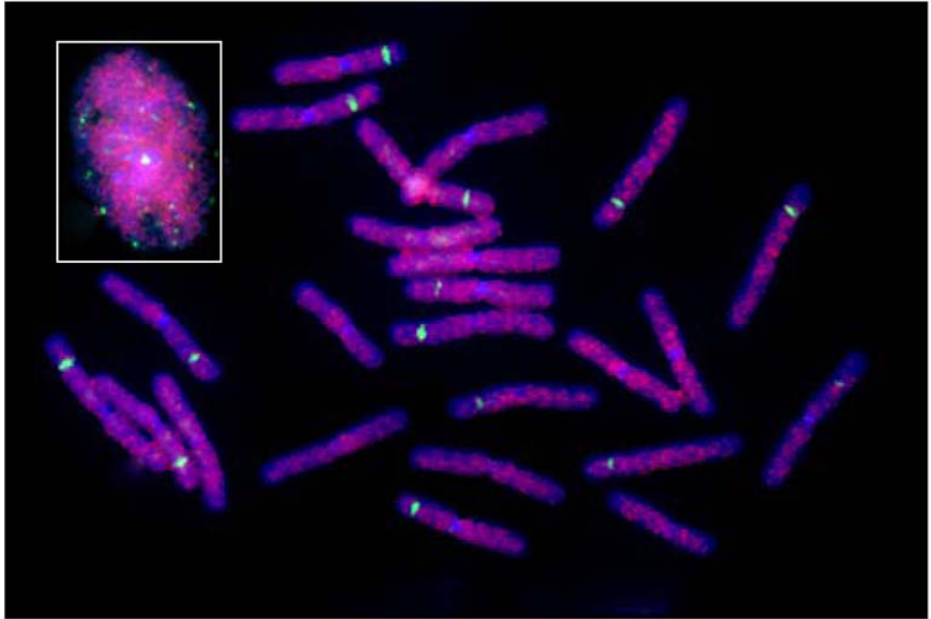
Figure 3. FISH showing the physical distribution of Gymny in somatic chromosome spread of Pinustaeda . RLG_ Gymny _EU912388-1 probes Fr1035 and Fr1075 were detected with Cy3 streptavidin (red) and 18S–28S rDNA was detected with FITC (green). Inset shows FISH to interphase nucleus.